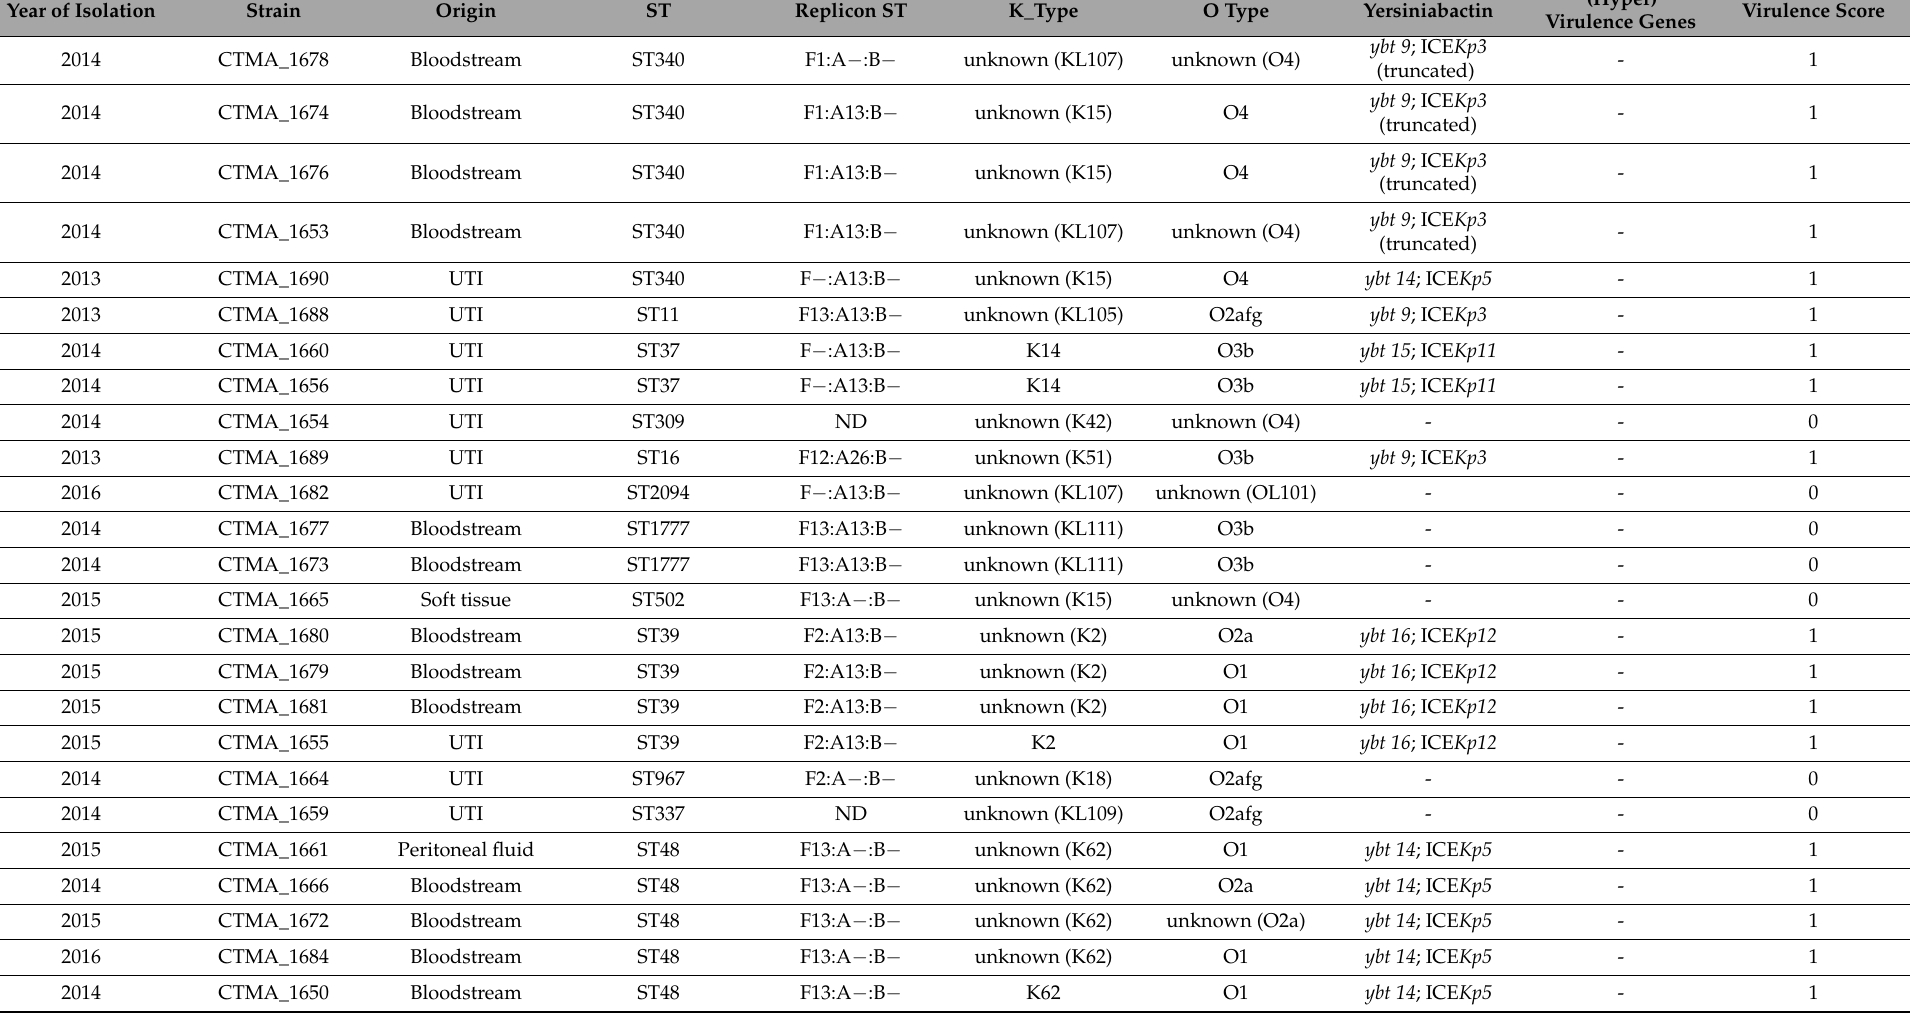
Table 3. MLST sequence type (ST), K and O and their respective K (capsule) and O antigen (LPS) type, as predicted by